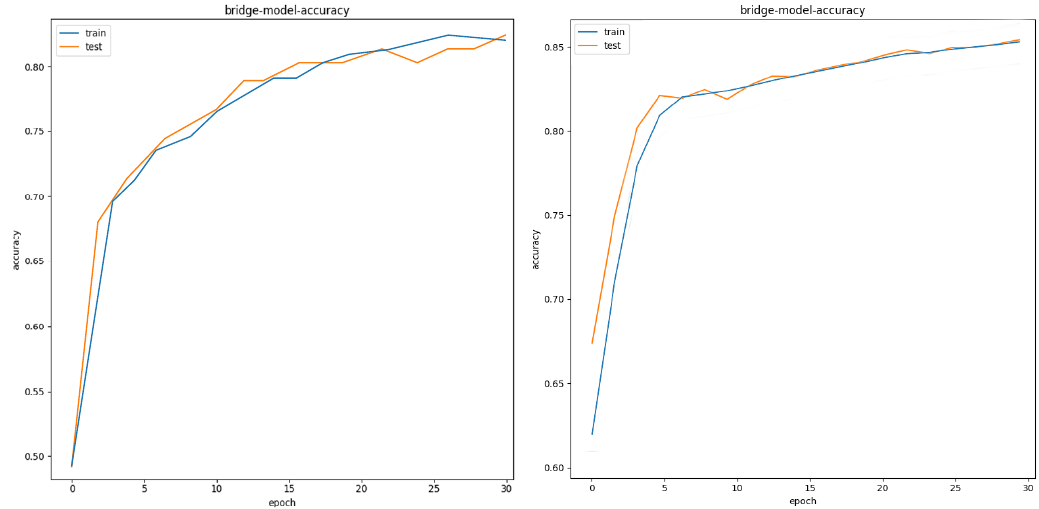
Figure 6. Accuracy before and after data set expansion.